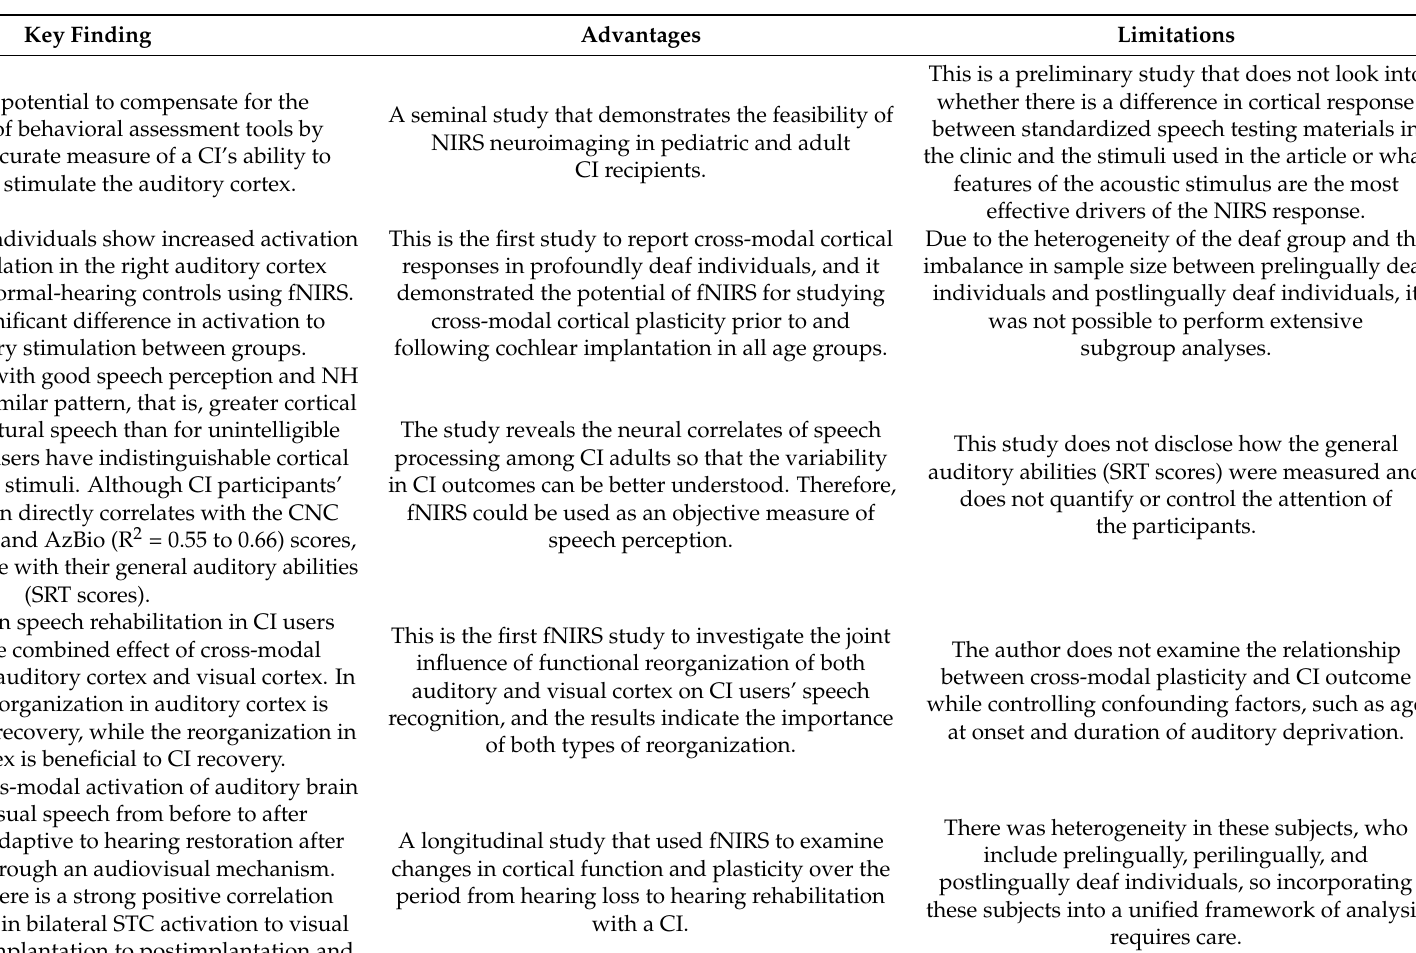
Table 3. Key findings and advantages in the milestone studies on the use of